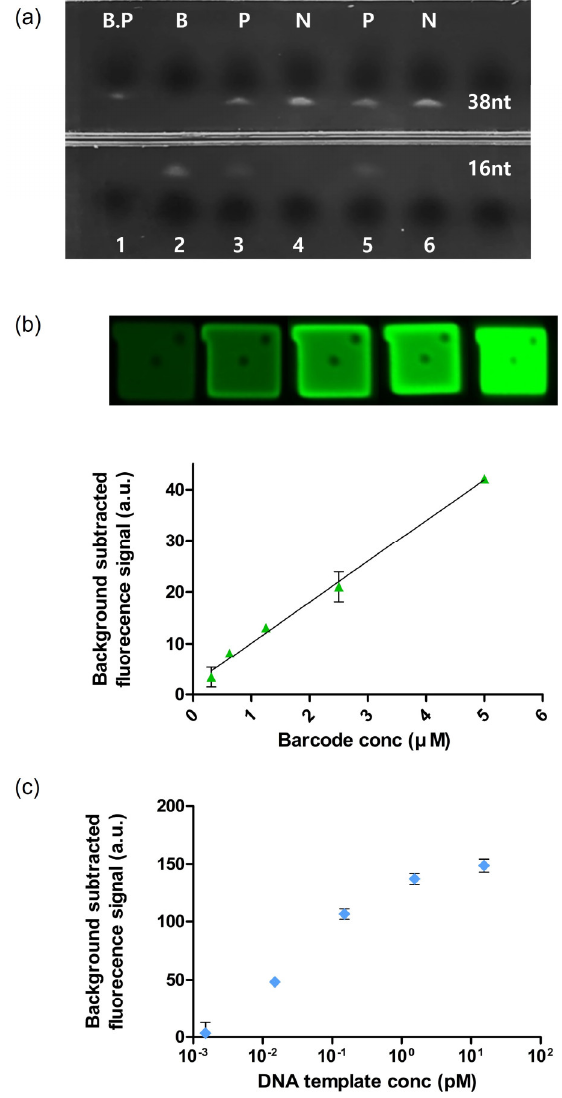
Figure 3. ( a ) PAGE to detect the size of the amplicon (16 nt). Lane 1: Barcode probe (38